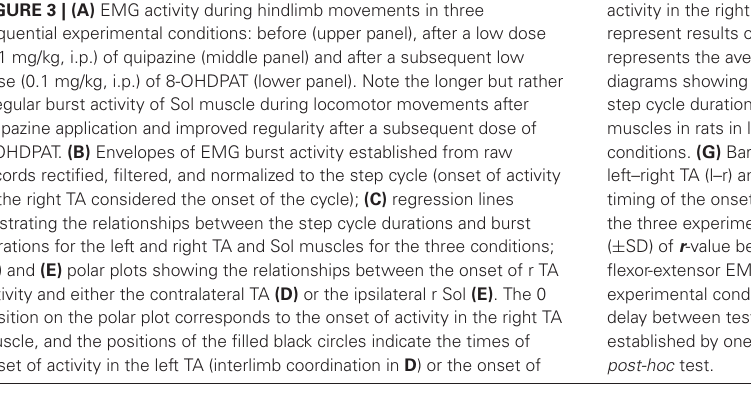
FIGURE 3 | (A) EMG activity during hindlimb movements in three sequential experimental conditions: before (upper panel), after a low dose (0.1 mg/kg, i.p.) of quipazine (middle panel) and after a subsequent low dose (0.1 mg/kg, i.p.) of 8-OHDPAT (lower panel). Note the longer but rather irregular burst activity of Sol muscle during locomotor movements after quipazine application and improved regularity after a subsequent dose of 8-OHDPAT. (B) Envelopes of EMG burst activity established from raw records rectified, filtered, and normalized to the step cycle (onset of activity in the right TA considered the onset of the cycle); (C) regression lines illustrating the relationships between the step cycle durations and burst durations for the left and right TA and Sol muscles for the three conditions; (D) and (E) polar plots showing the relationships between the onset of r TA activity and either the contralateral TA (D) or the ipsilateral r Sol (E) . The 0 position on the polar plot corresponds to the onset of activity in the right TA muscle, and the positions of the filled black circles indicate the times of onset of activity in the left TA (interlimb coordination in D ) or the onset of